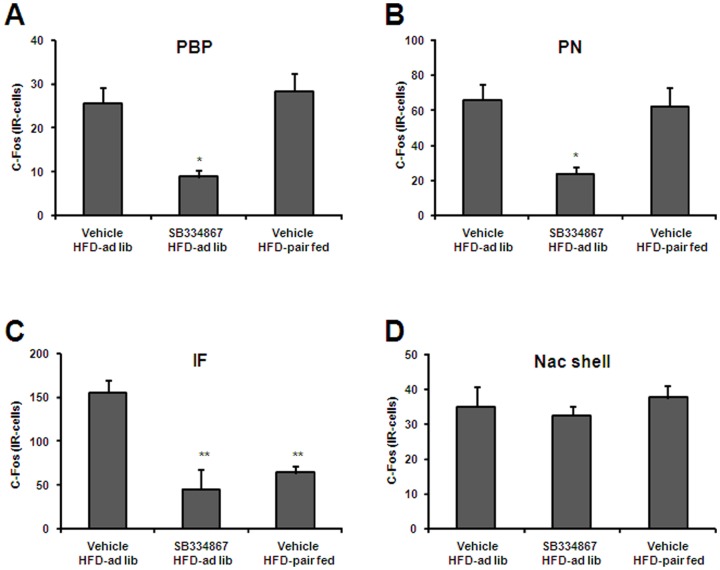
Orexin signaling blockade reduces HFD-induced increase of c-Fos in the VTA and not in the NAc.Panels A-D show quantitative analysis of c-Fos staining in specific PBP (A), PN (B) and IF (C) sub-regions of the VTA, and in the NAc shell (D) of vehicle-HFD-ad lib, SB334867-HFD-ad lib and vehicle-HFD-pair-fed groups. Histograms depict the total number of c-Fos-IR neurons, expressed as cells per coronal section. Values are the mean±SEM. *, p<0.05 vs. vehicle HDF-ad lib group. **, p<0.01 vs. vehicle HDF-ad lib group.